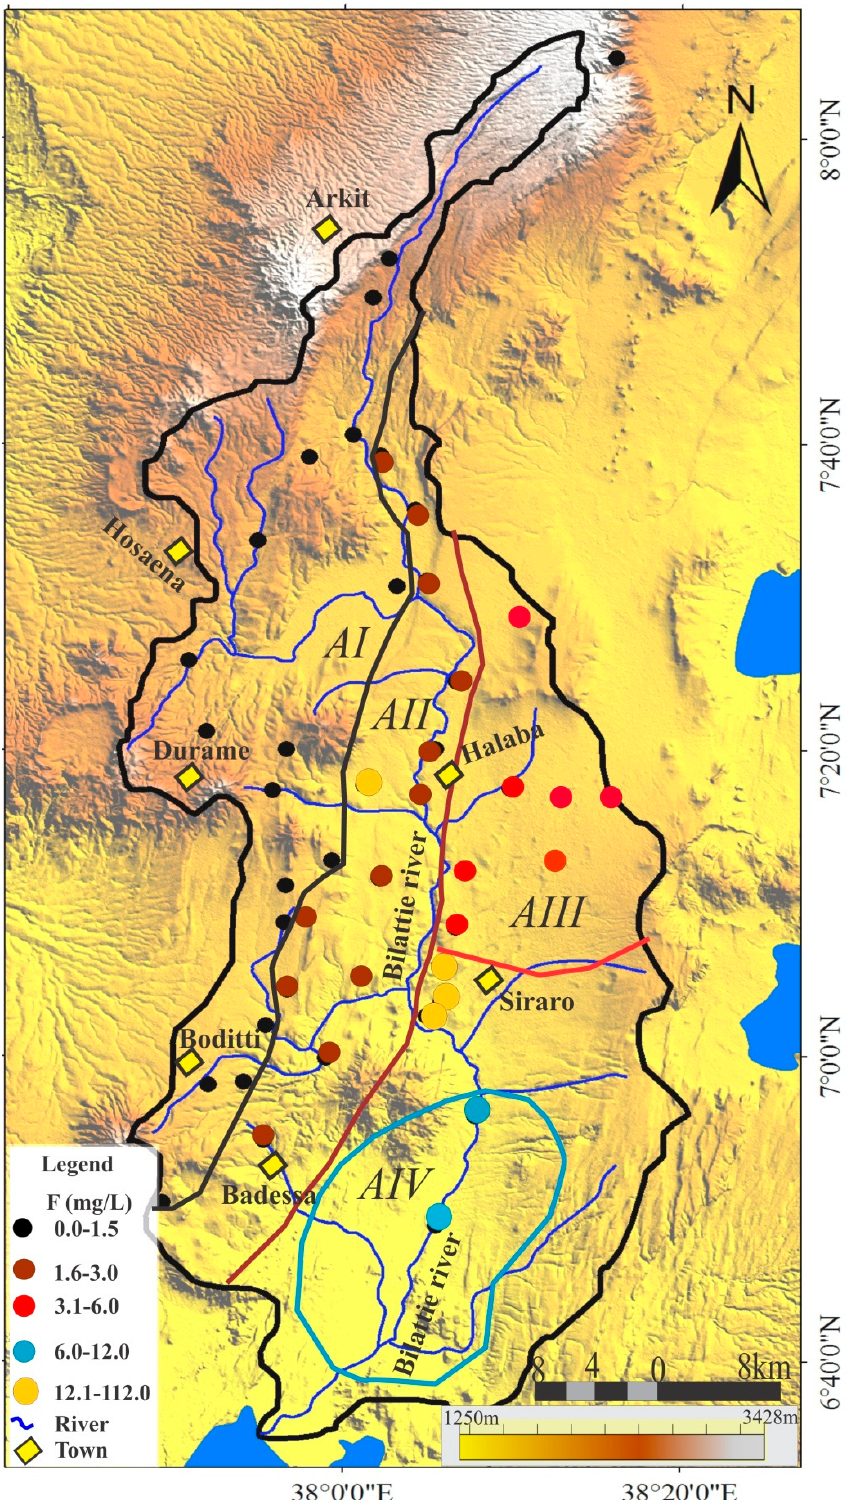
Figure 4. Spatial distribution of F − in groundwater of Bilate River basin. Note: black, brown, red and light-blue lines are used as approximate demarcation of areas with different fluoride concentration.